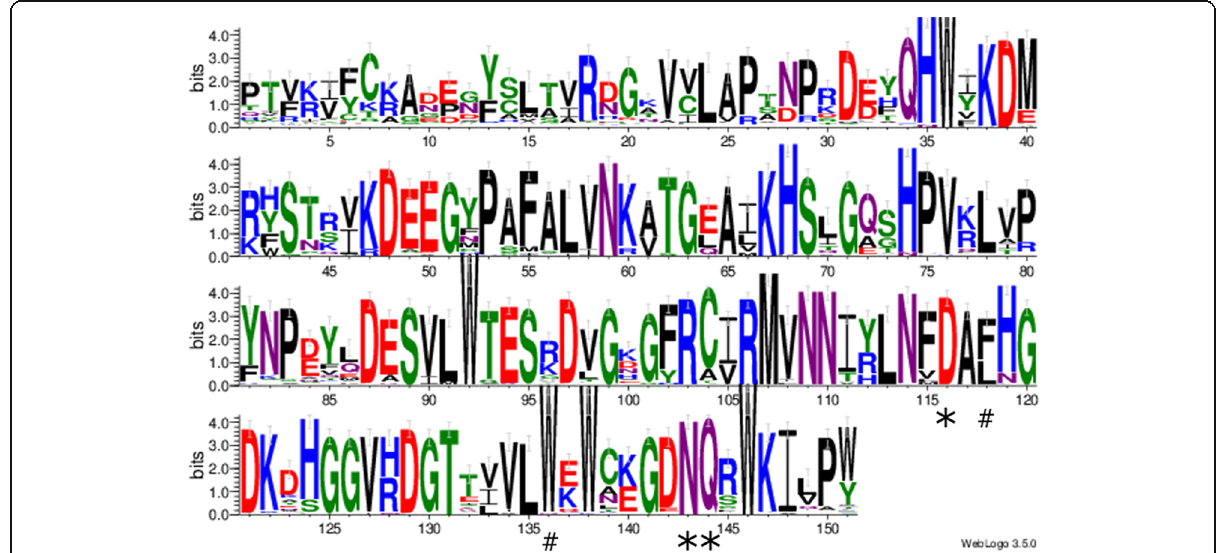
Fig. 7 Sequence logo for the EUL domains of all species under study. Amino acid residues forming the active triad of the carbohydrate-binding site are indicated with an asterisk (*). Aromatic residues involved in stacking interactions with the sugars are indicated by a hash